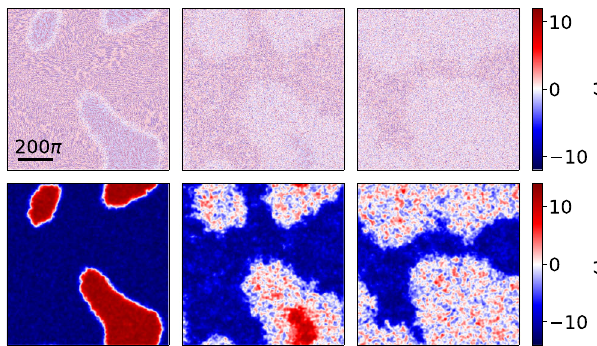
fi eld ω for λ = 5.6 at different times (initial condition, at t = 1000, and at t = 2000). Bottom row shows the corresponding smoothed fi elds ω theoretical curves are obtained by fi tting (4) to the numerical data. The corre- sponding values of the free parameters δ and τ are, respectively, 4.97 and 54.59 for L = 10 π (blue curve), 10.40 and 72.78 for L = 20 π (orange curve) and 21.67 and 72.81 for L = 40 π (green curve). Melting transition on large domains . To evaluate the melting transition curve on large domains (Fig. 5c), we fi rst identify centers of the strong vortices 47,74 . Then an order parameter fi eld is obtained by calculating, for each point ( x , y ), the difference between the number of positive and negative vortices within a circle of radius r centered at ( x , y ) ( r is about 1.5 times the mean distance between the nearest neighbors). The resulting fi eld is then smoothed using a Gaussian fi lter with standard deviation σ = 12. The original vorticity fi eld ω and the smoothed fi eld ω s are shown in Fig. 8. The turbulent region is then de fi ned as the area where the absolute value of this smoothed fi eld is less than half the maximum value of the fi eld. Once this turbulent region is de fi ned, the order parameter A A AVL / total is calculated by evaluating the fraction of the total area covered by the AVL.